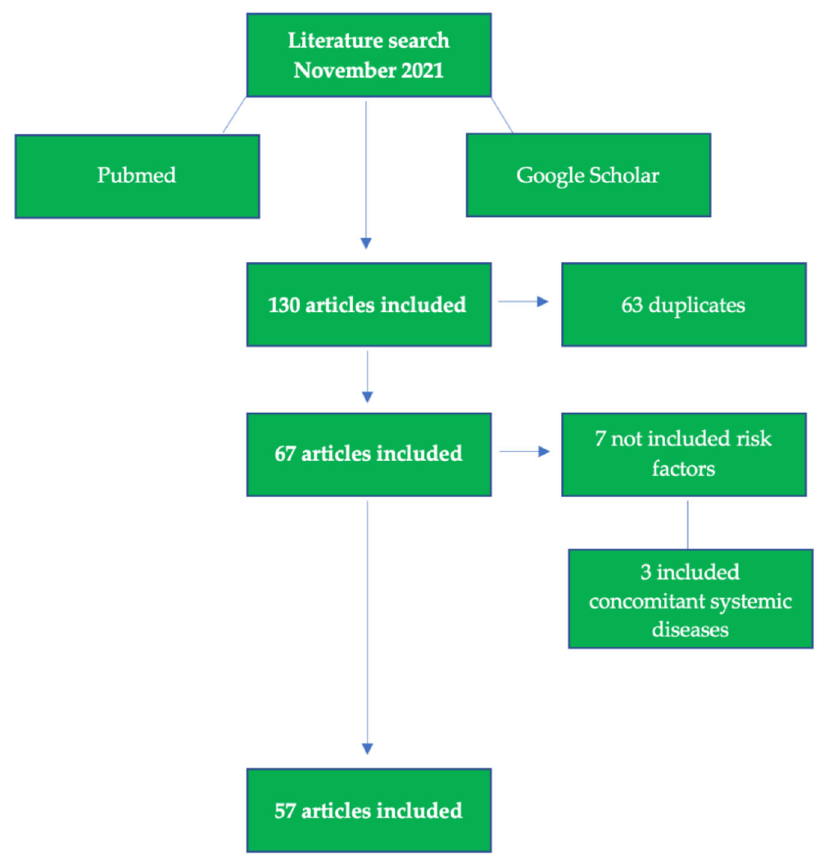
Figure 1. Flow chart of included studies.